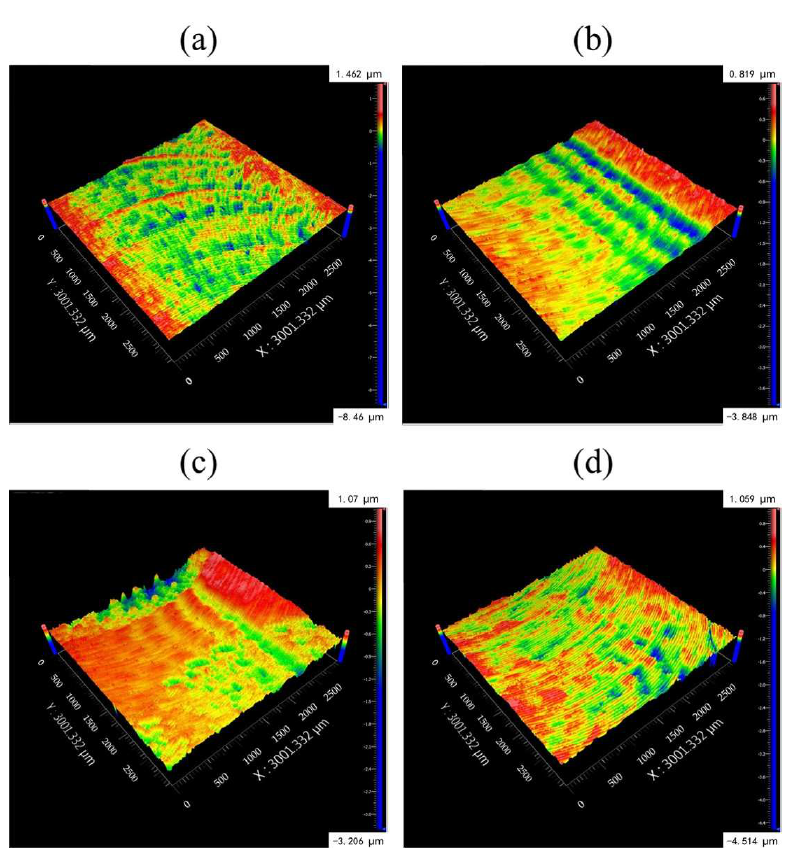
Figure 3. WLI images of the surfaces of a milled workpiece. The denotations ( a – d ) represented four different positions randomly selected on these surfaces, respectively.